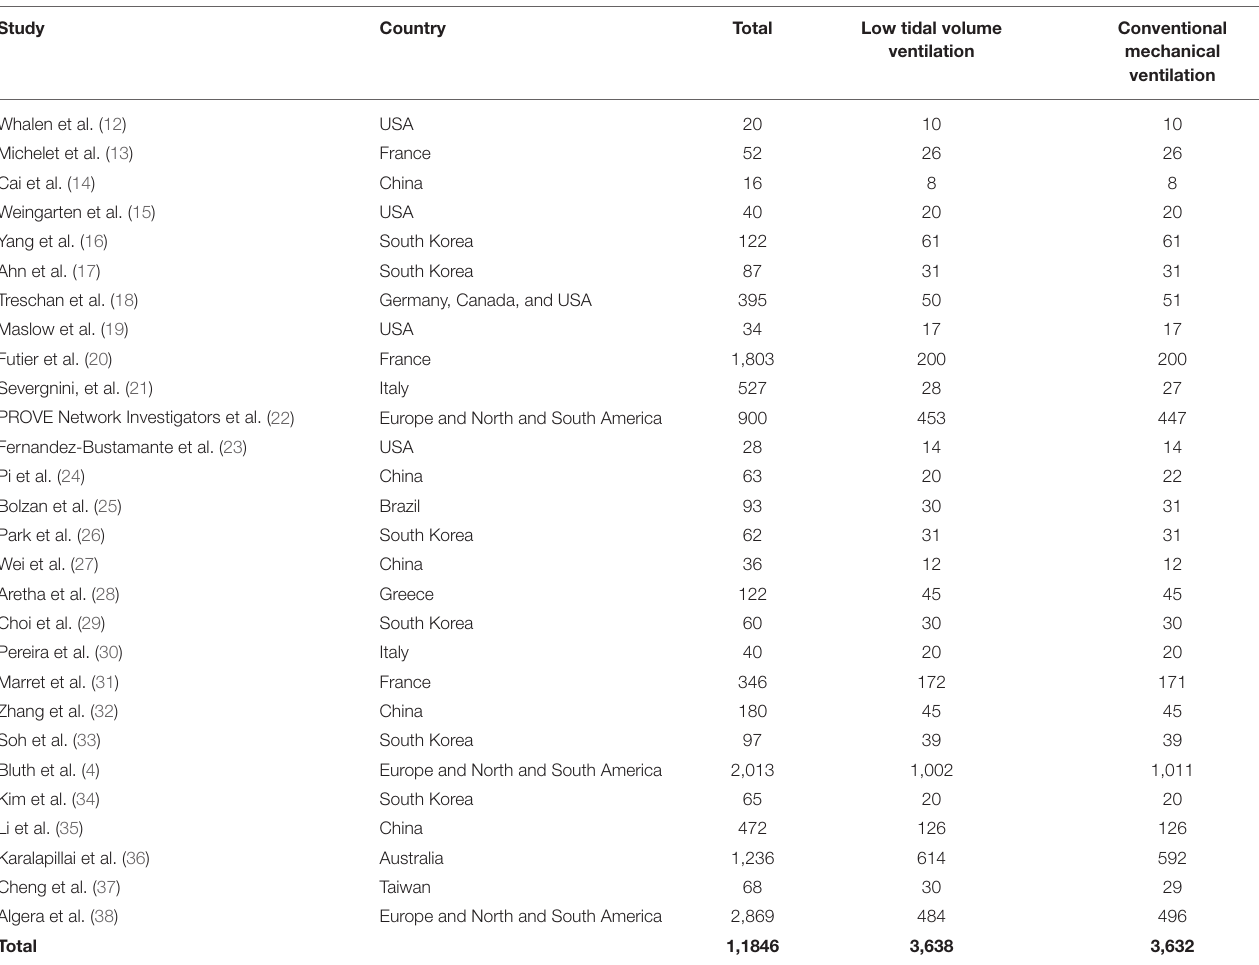
TABLE 2 | Characteristics of the selected studies for the meta-analysis.